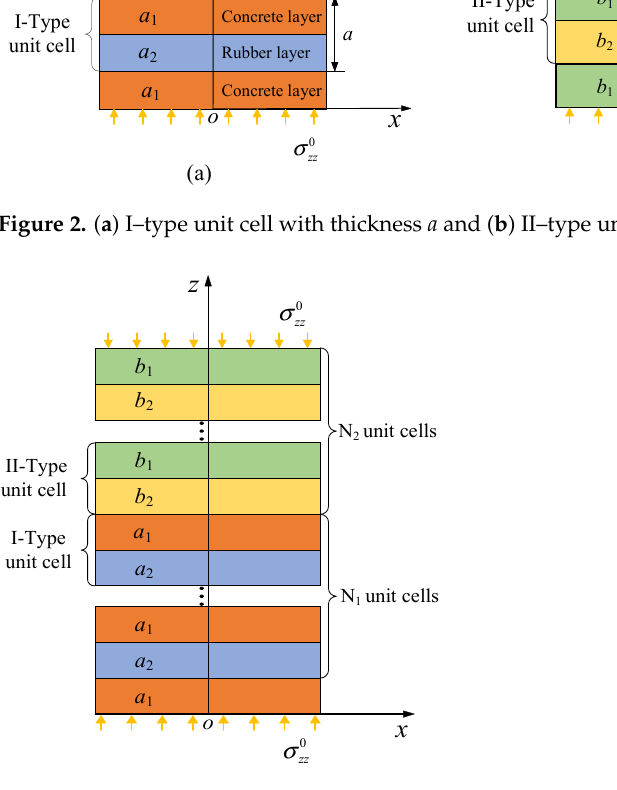
Figure 3. Combined layered periodic foundation with N 1 Ι –type and N 2 ΙΙ –type unit cells. For simplicity, the top boundary of the CLPF is assumed to be stress free. A harmonic displacement excitation Ψ = δ e i ω t is applied to the bottom boundary of the CLPF, where δ is the amplitude of the excitation. By using the weak form quadrature element method, dynamic governing equations of the CLPF can be written as